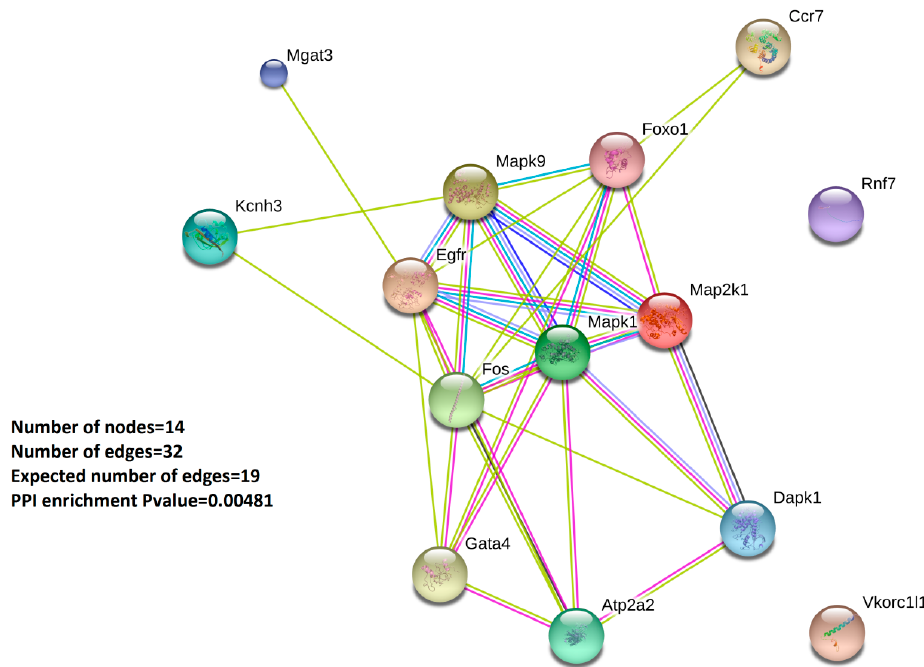
Figure 3. STRING Protein-Protein Interaction network of the 14 validated Oxstress mRNAs. Network nodes (colored circles) represent proteins, with a single node representing all the proteins produced by a single protein-coding gene, including splicing isoforms alternative polyadenylation forms, etc. Colored lines between the nodes (edges) indicate the di ff erent types of interaction evidenced by fusion of genes (red line), neighborhood of genes (green line), cooccurrence across species (blue line), experimental evidence (purple line), text mining of abstracts from literature (yellow line), databases (light blue line), co-expression in the same or others species (black line).